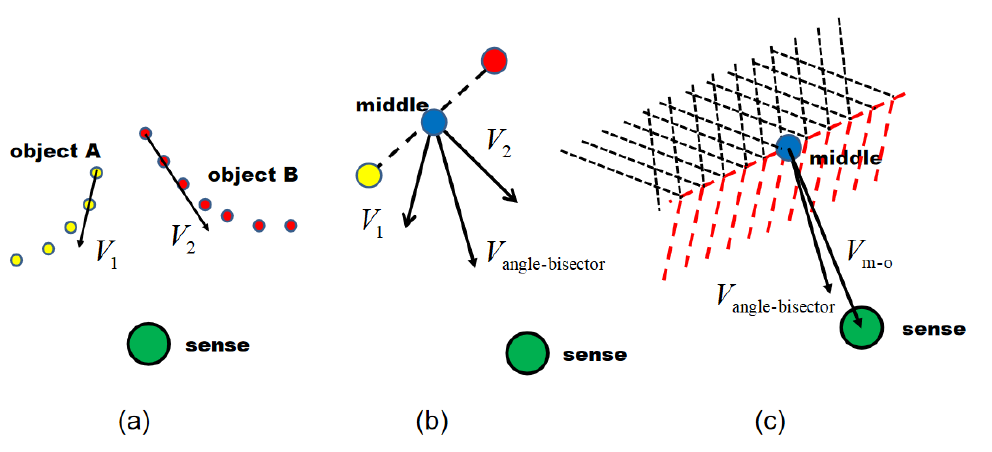
Figure 5. ( a ) The V 1 and V 2 from adjacent point clouds. ( b ) The V angle − bisector is the corner bisector